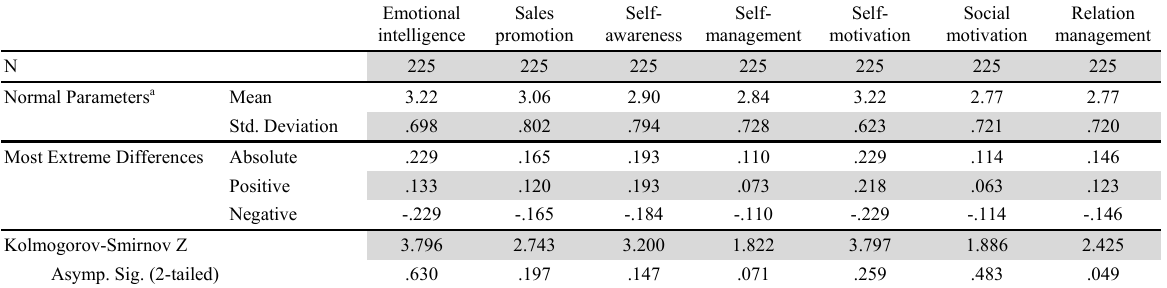
Results of the normality test related to research variables